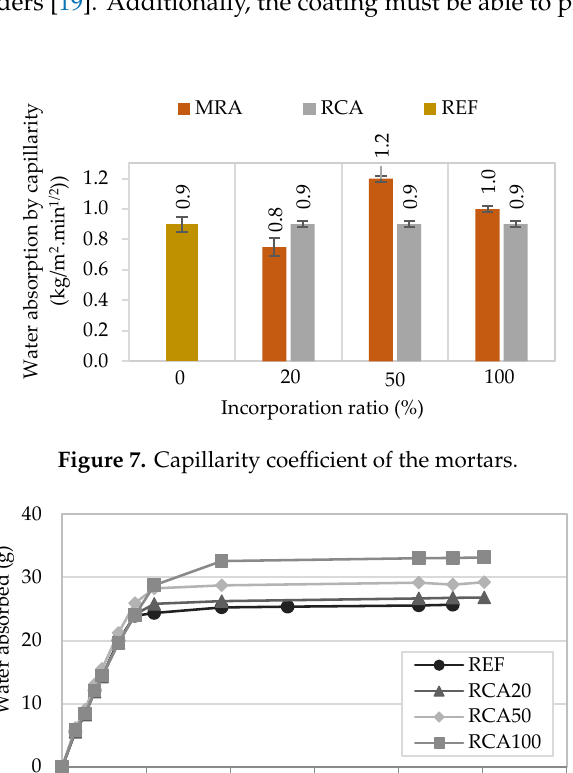
Figure 8. Water absorption by capillarity action tests results of recycled RCA mortars.